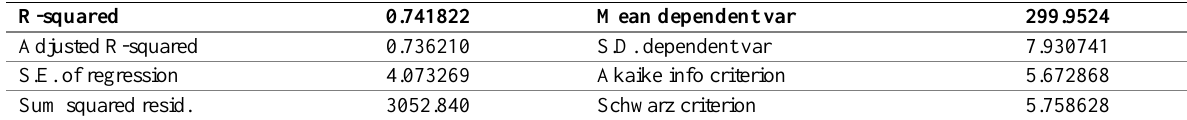
Table 6: The Coefficient of Determination (R 2